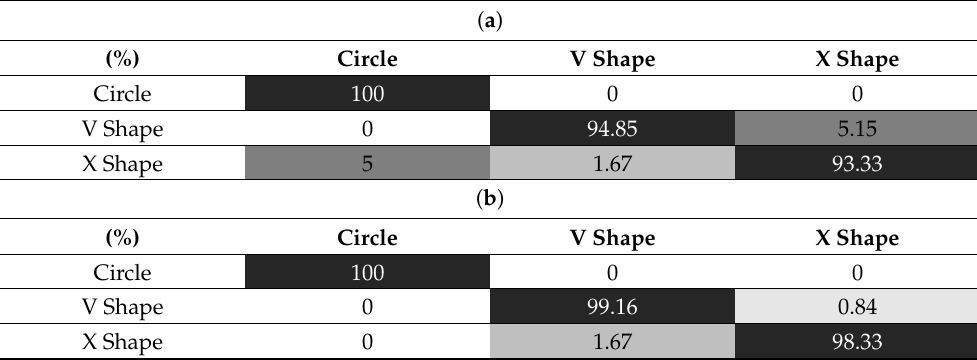
Table 1. Hand gestures classification performance with public data. ( a ) RNN-BiLSTM; ( b ) RNN-GRU.